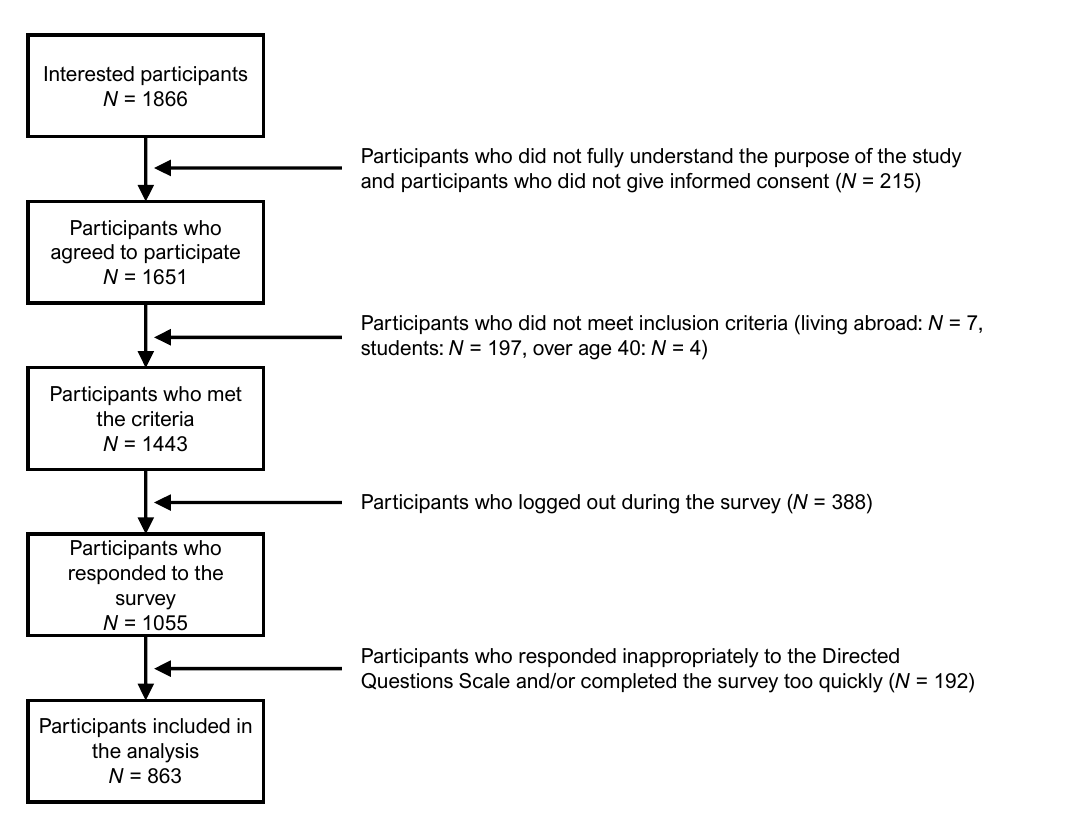
Figure 1. Procedures for recruiting participants in this study. Table 1. Sample Characteristics ( N = 863) 1.